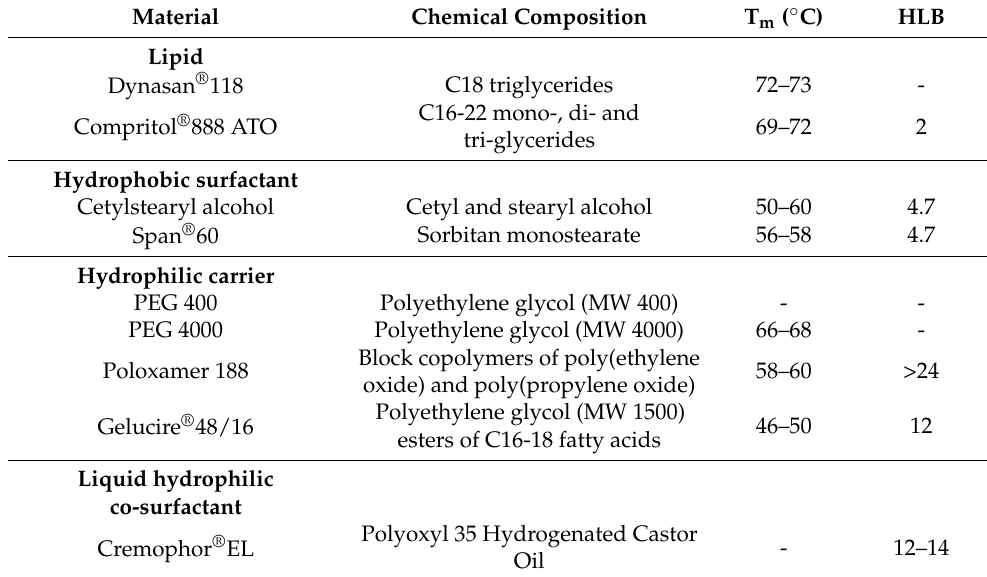
Table 1. Characteristics of the materials used for the production of biphasic